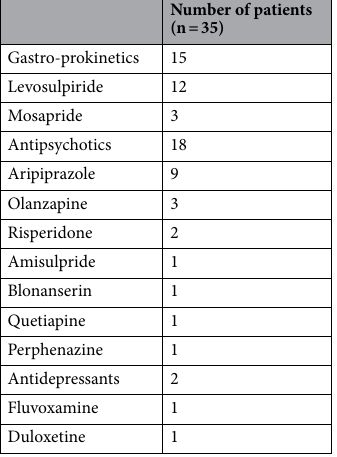
Number of patients (n =